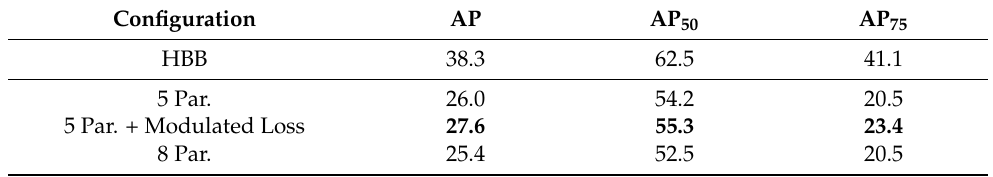
Table 14. Comparing RetinaNet predicting horizontal bounding boxes (HBBs) and oriented bounding boxes (OBBs) in different configurations. Both bounding box types are trained and evaluated on their respective dataset type. While the AP is heavily impaired, the AP 50 is only slightly reduced when predicting OBBs since the precise estimation of the angle is not important for objects with a ratio close to 1 to achieve an IoU above 50%. Among the tested configurations, predicting the usual bounding box parameter and an angle while using modulated loss to handle angle periodicity achieves the best